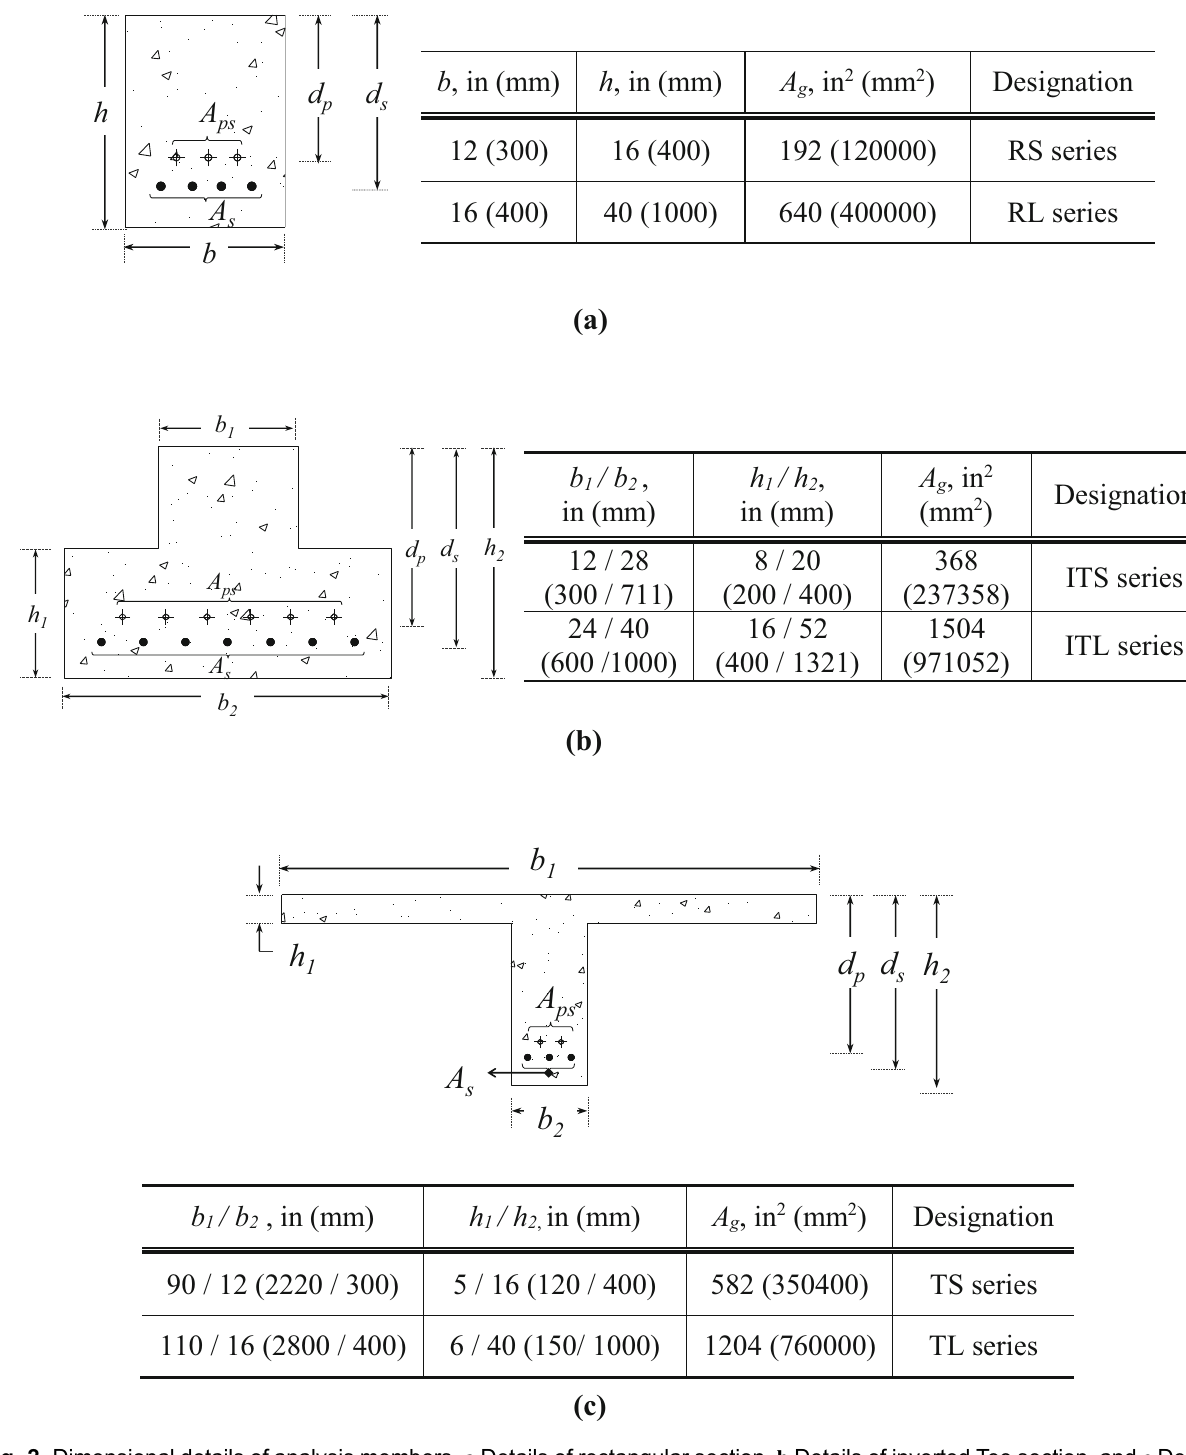
Fig. 2 Dimensional details of analysis members. a Details of rectangular section, b Details of inverted Tee section, and c Details of double Tee